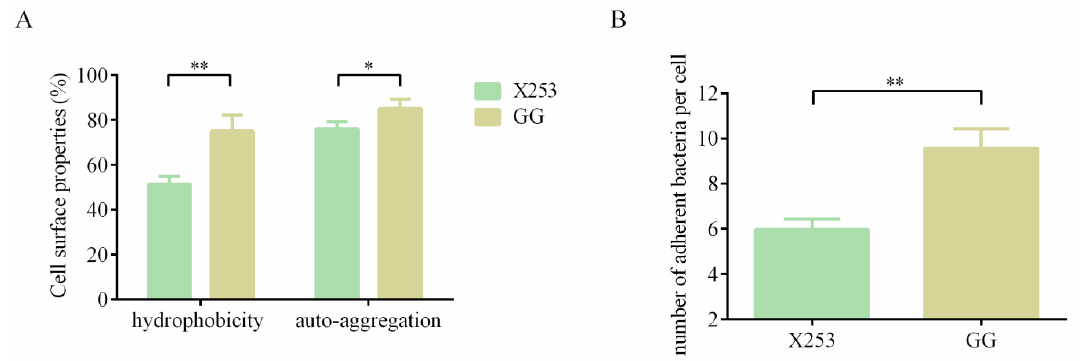
Figure 5. Comparative analysis of L. rhamnosus X253 and L. rhamnosus GG for hydrophobicity, auto-aggregation and adhesion to CaCo-2 cells; *: p < 0.05, **: p < 0.01. ( A ) Hydrophobicity and auto-aggregation. ( B ) Adhesion to CaCo-2 cells.